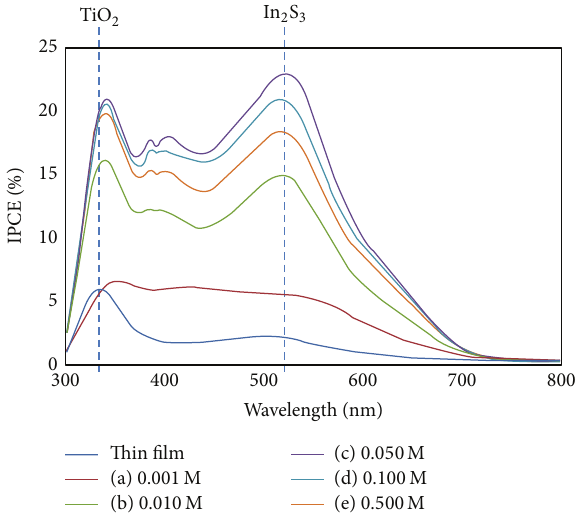
Figure 5: Incident photon-to-current conversion efficiencies of the TiO 2 seed blocking/In 2 S 3 photosensitizer layered-solar